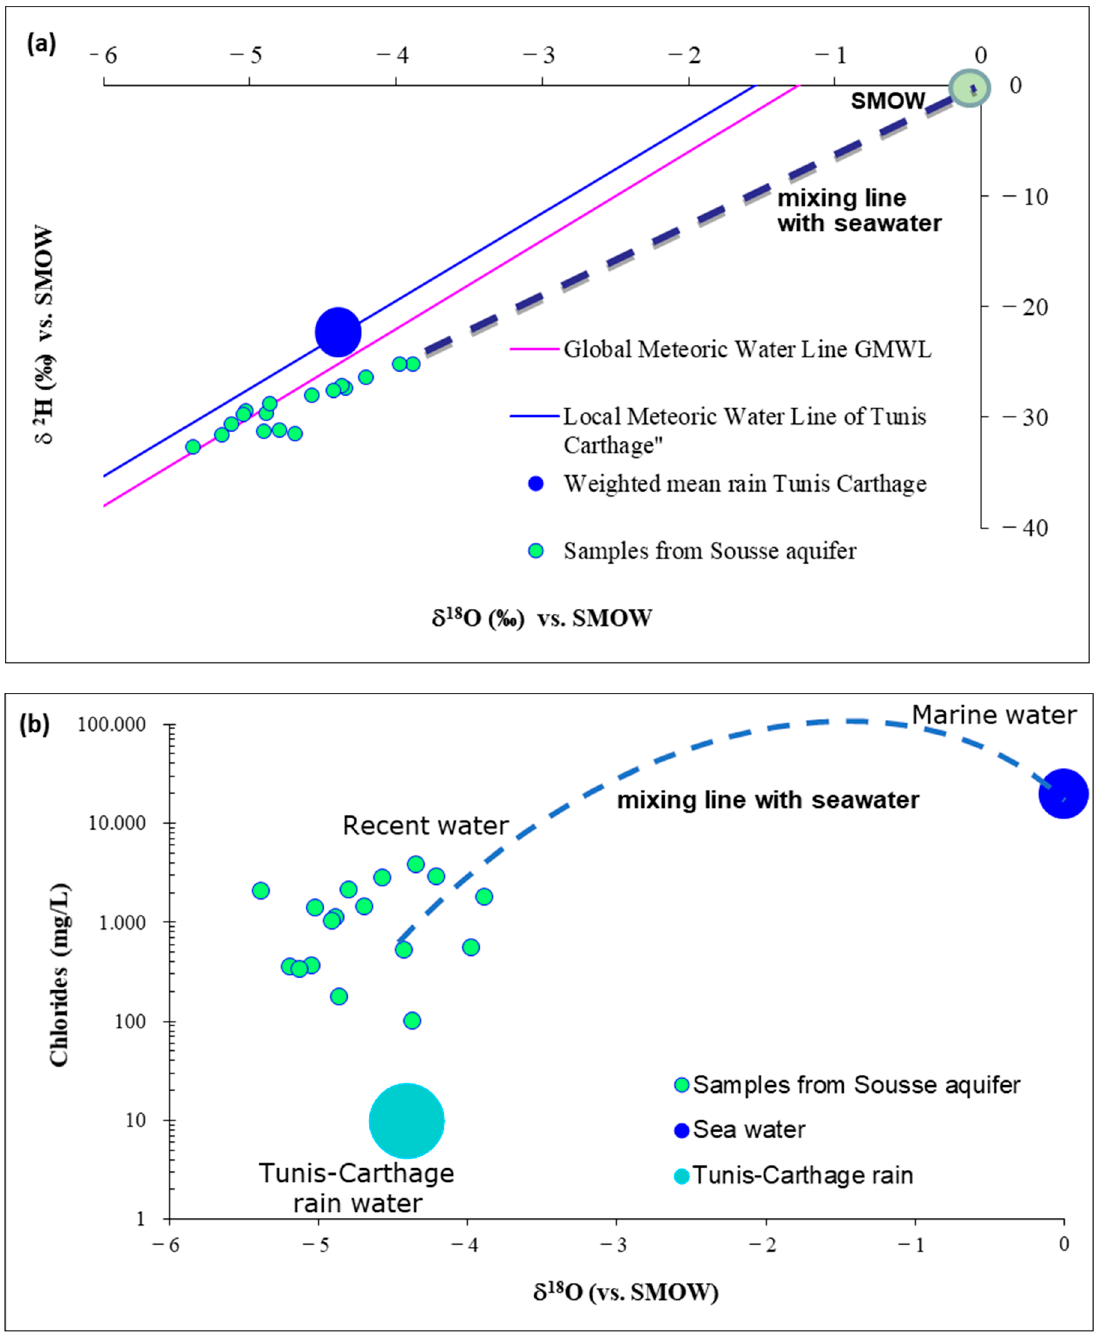
Figure 11. ( a ) δ 2 H – δ 18 O diagram of the sampled waters [23]. ( b ) Plot of Cl − vs. δ 18 O ‰ (V-SMOW) [23].